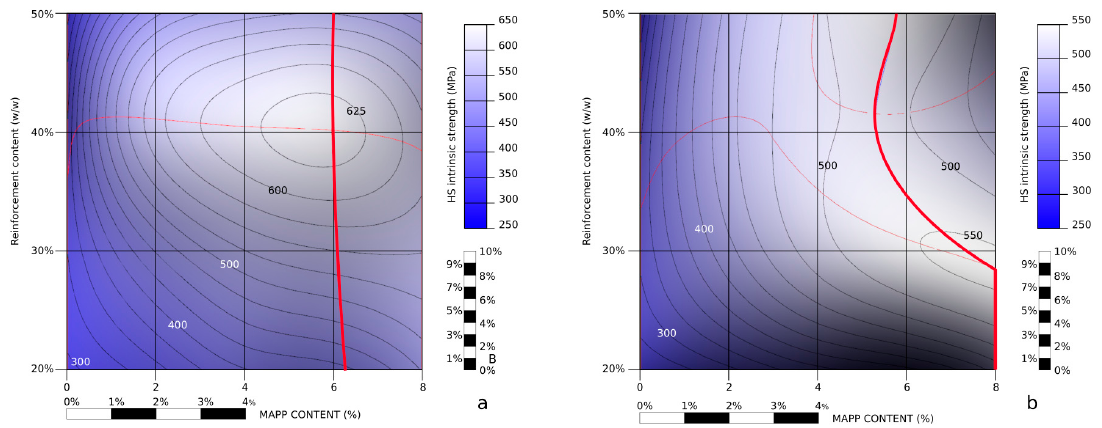
Figure 7. Topographic profile of the intrinsic tensile strength of the reinforcement against coupling agent and reinforcement contents; ( a ): maintaining the values obtained for χ 1 , ( b ): imposing a constant 0.3 orientation angle.